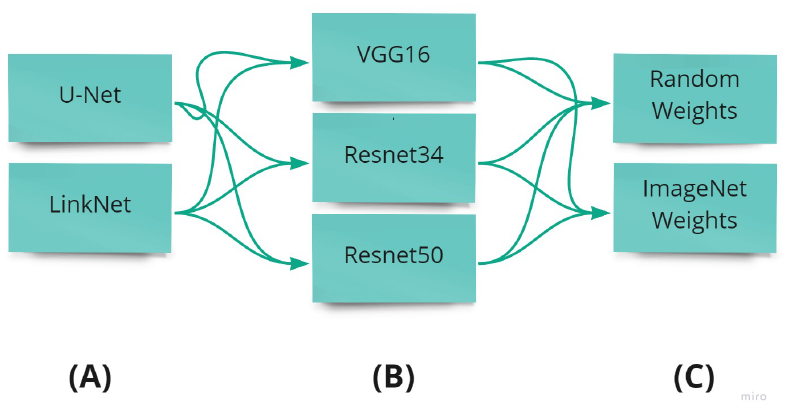
Figure 5. Conducted experiments, where ( A ) are models, ( B ) are backbones, and ( C ) are weight initialization, where “None” is the initialization of the weights carried out